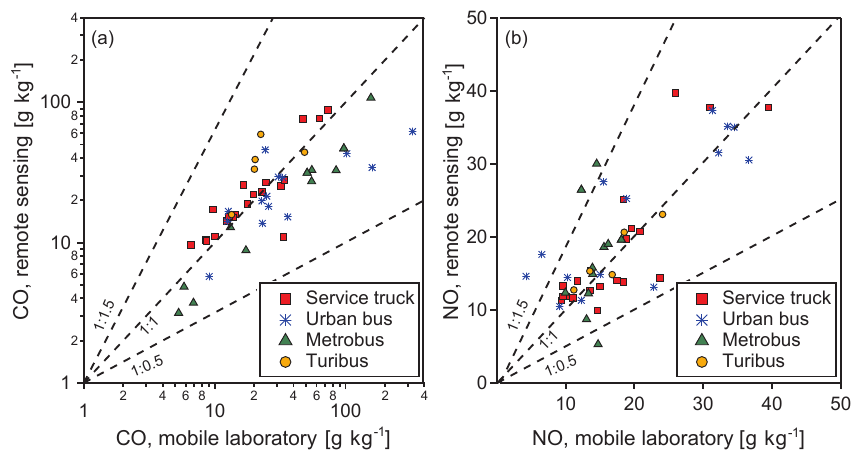
Figure 4. Comparison of (a) CO and (b) NO fuel-based emission factors measured with the mobile laboratory and remote sensing techniques. Dashed lines represent 1 : 1 . 5, 1 : 1, and 1 : 0 . 25